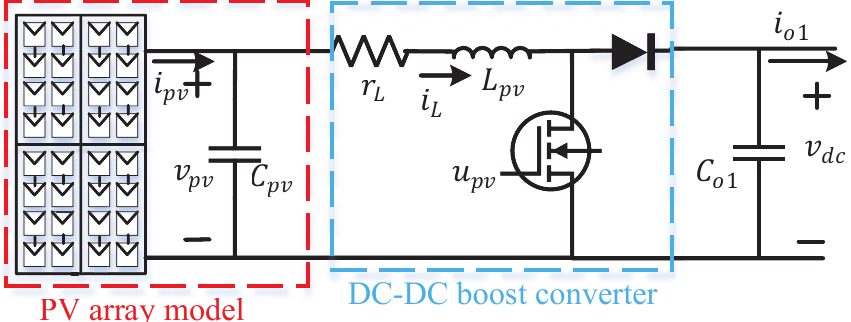
Figure 2. A solar PV system with a DC–DC boost